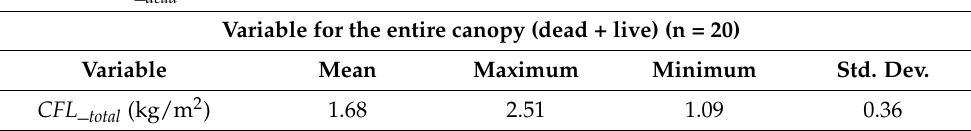
Table 3. Statistics for the main variables in the first 6 m of dead canopy and the entire canopy.